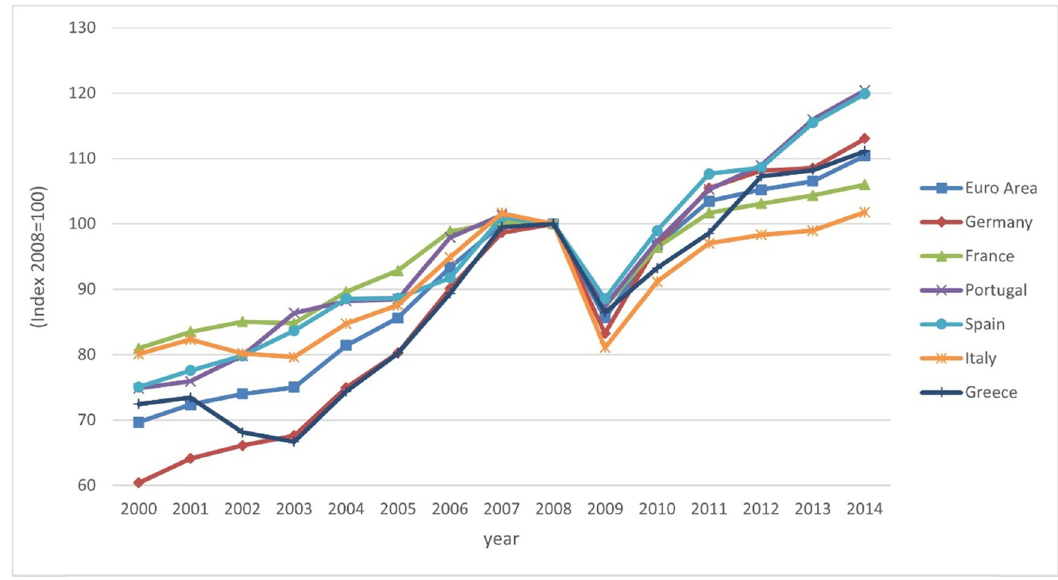
Figure 3: Evolution of exports. Source: AMECO -